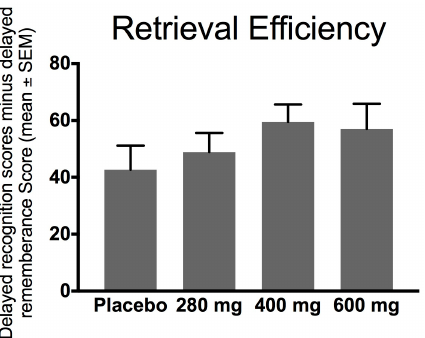
Figure 5. Retrieval efficiency calculated using the Korean version of the Rey Auditory Verbal